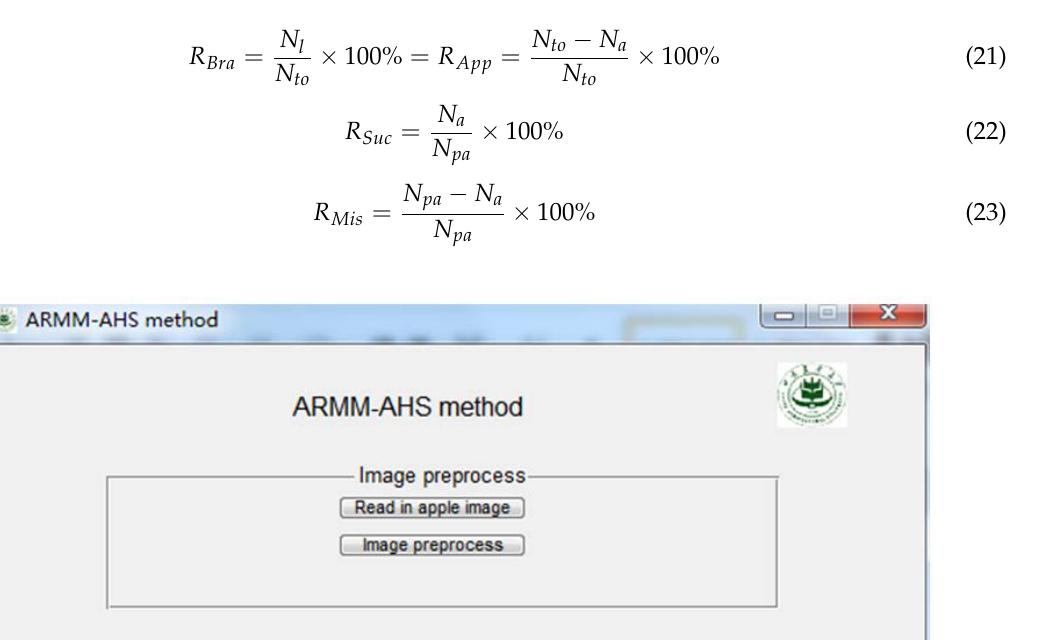
Figure 13. Comparison of the average optimum with different harmony memory sizes of five functions.